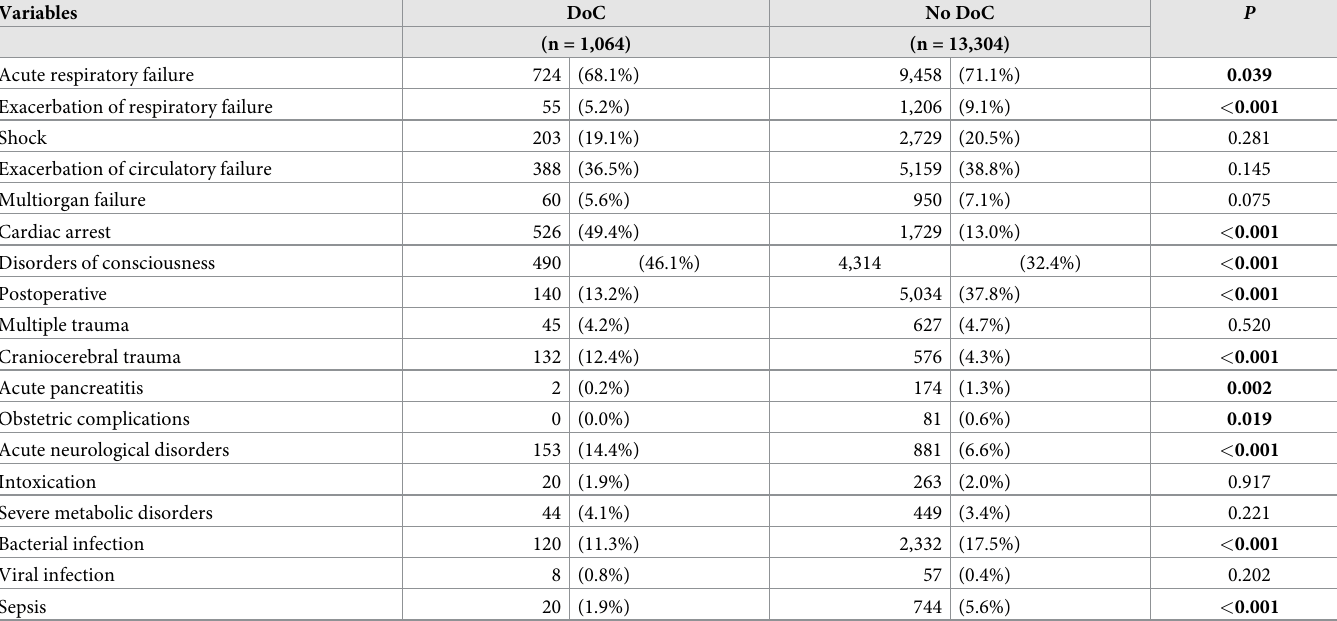
Table 2. Primary reason for ICU admission among patients discharged from the ICU with or without